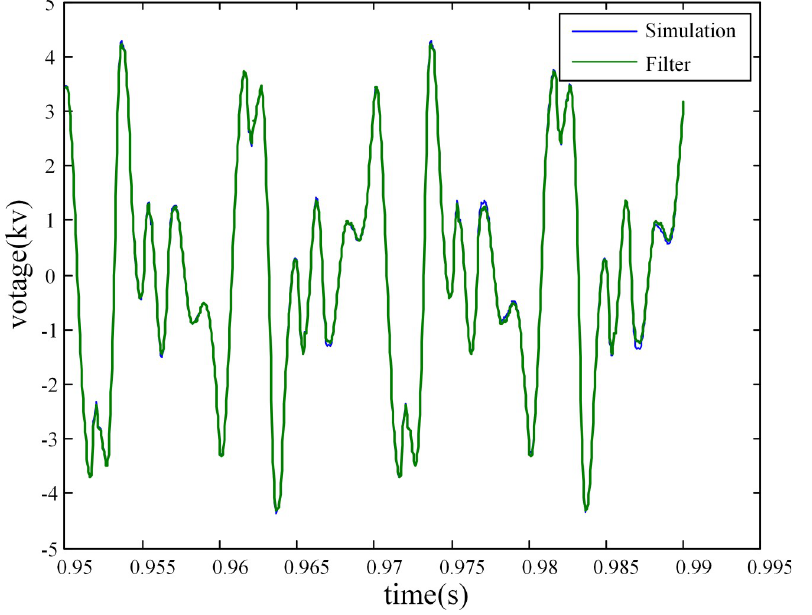
Fig 17. Total harmonic voltage of the 500-kV bus.